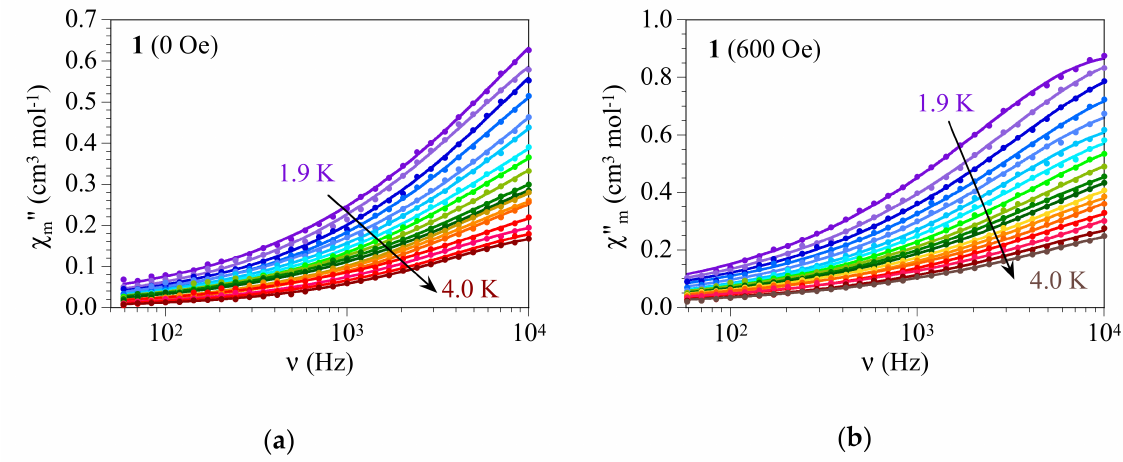
Figure 8. ( a ) Frequency dependence of χ (cid:48)(cid:48) m for compound 1 with H dc = 0 Oe in the temperature range 1.9–4.0 K; ( b ) Frequency dependence of χ (cid:48)(cid:48) m for compound 1 with H dc = 600 Oe in the temperature range 1.9–4.0 K. Solid lines are the best fit to the Debye